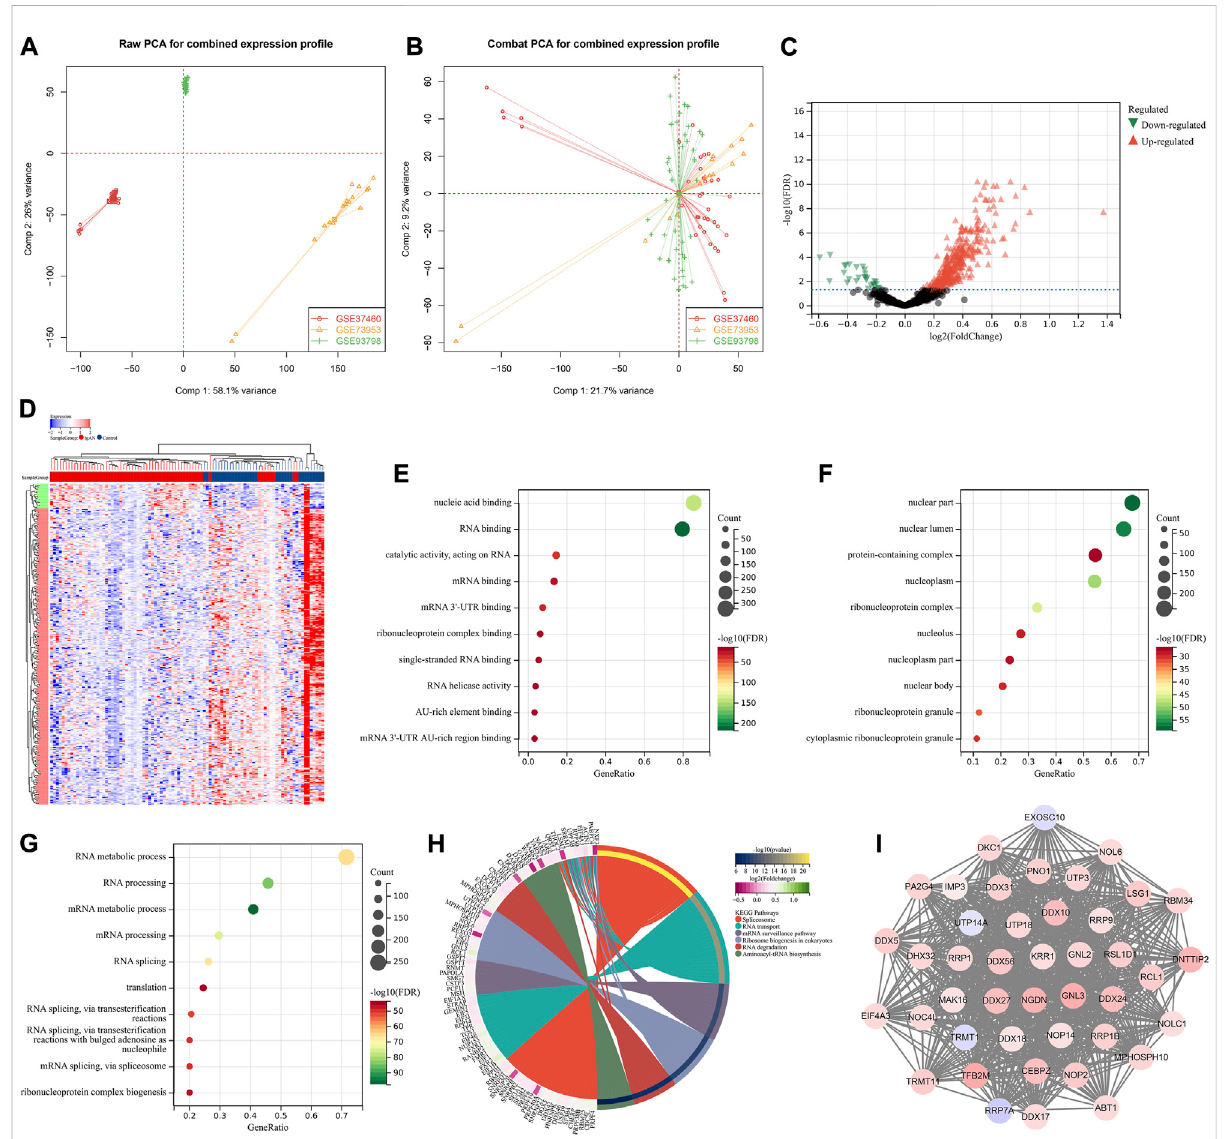
FIGURE 2 Identi fi cation of hub RBPs in IgA nephropathy. (A, B) PCA plots for combined transcriptomic pro fi ling of GSE37460, GSE73953, and GSE93798 datasets before and after batch correction. (C) Volcano diagram for the up- and down-regulated RBPs in IgA nephropathy than normal samples. Red,up-regulatedRBPs; black, notsigni fi cantRBPs; green,down-regulatedRBPs. (D) Heatmapofthedifferentialexpression ofRBPs inIgA nephropathy and normal samples. Red, up-regulation; blue, down-regulation. (E – G) The top ten biological processes, cellular components, and molecular functions signi fi cantly enriched by RBPs with differential expression. (H) KEGG pathways signi fi cantly enriched by RBPs with differential expression. (I) The important module derived from PPI network of RBPs with differential expression. IgAN, IgA